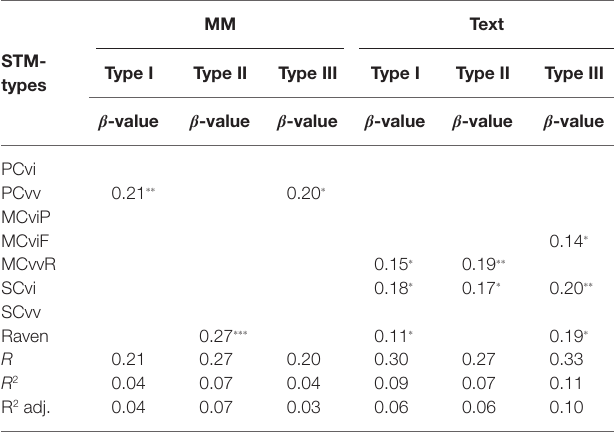
TABLE 6 | Stepwise regression analysis for the capacity of various STM-types (substructures) and learning outcomes from three instruments in multimedia (relative